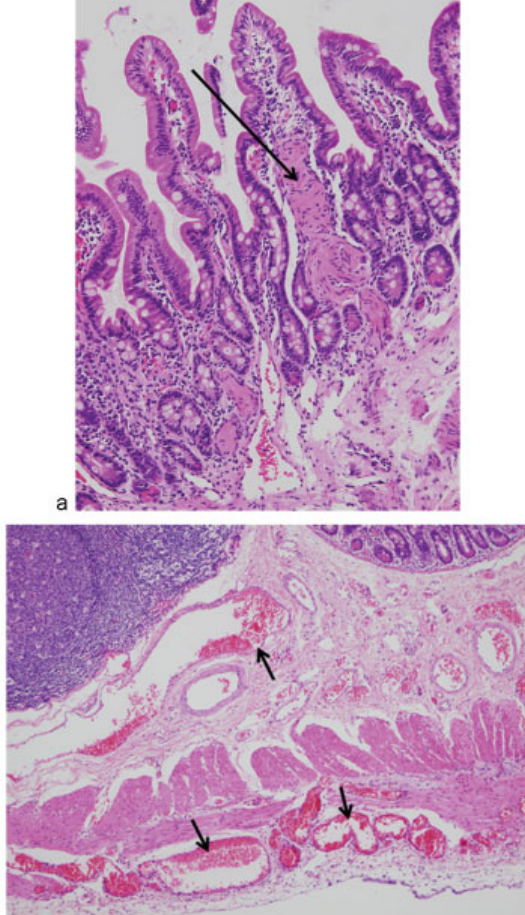
Fig. 2 (a) Endoscopic duodenojejunal biopsy: At the level of the submucosa, a conglomerate of thick-walled hamartomatous vessels is clearly observed. (b) Operative specimen of the ampullary region: Several tortuous vessels, with arterial and venous patterns, suggestive of arteriovenous malformation are seen in the submucosa.